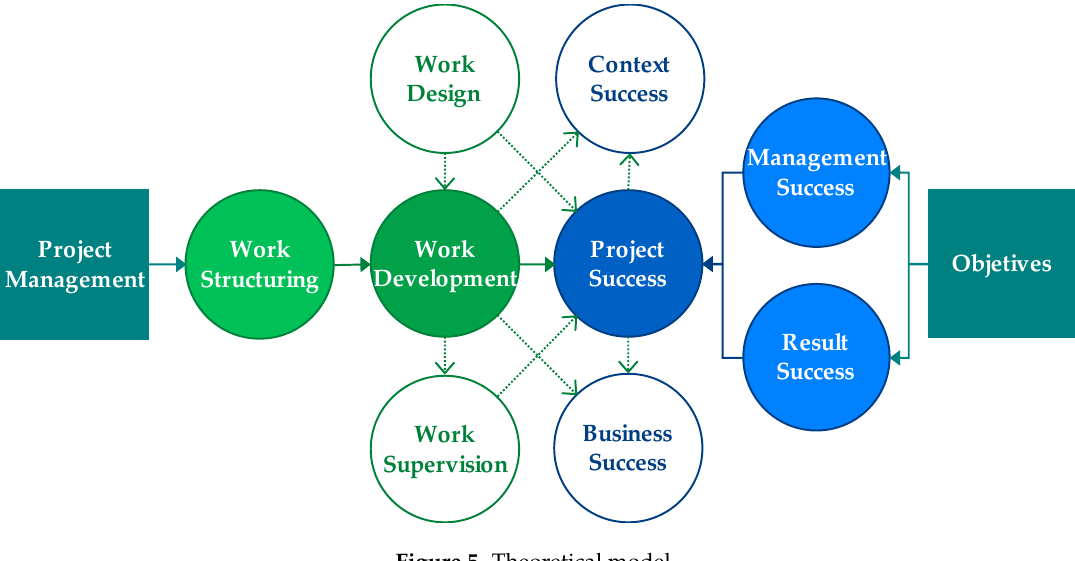
Figure 5. Theoretical model.